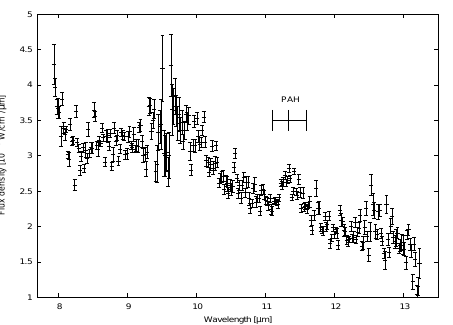
Figure 4: The mid-infrared spectrum of V2676